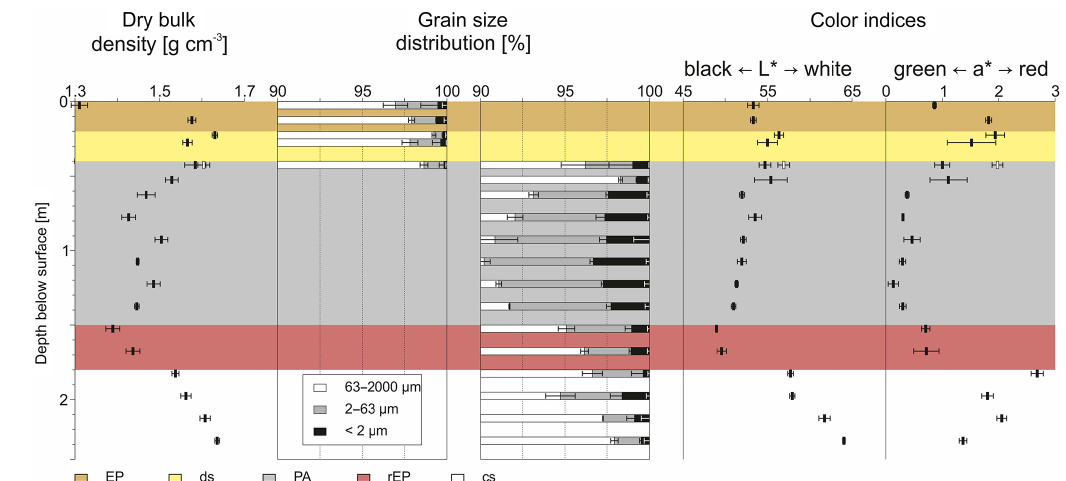
Figure 3. Physical properties of the profile, including dry bulk density, grain size distribution (left part of the diagram shows EP and ds horizon, right part reveals PA, rEP and cs), as well as color indices L ∗ (lightness) and a ∗ (redness). Symbol and column height represent thickness of sampled interval (0.05m). At 0.4m depth, ds (white symbols) and PA (black symbols) were analyzed separately.